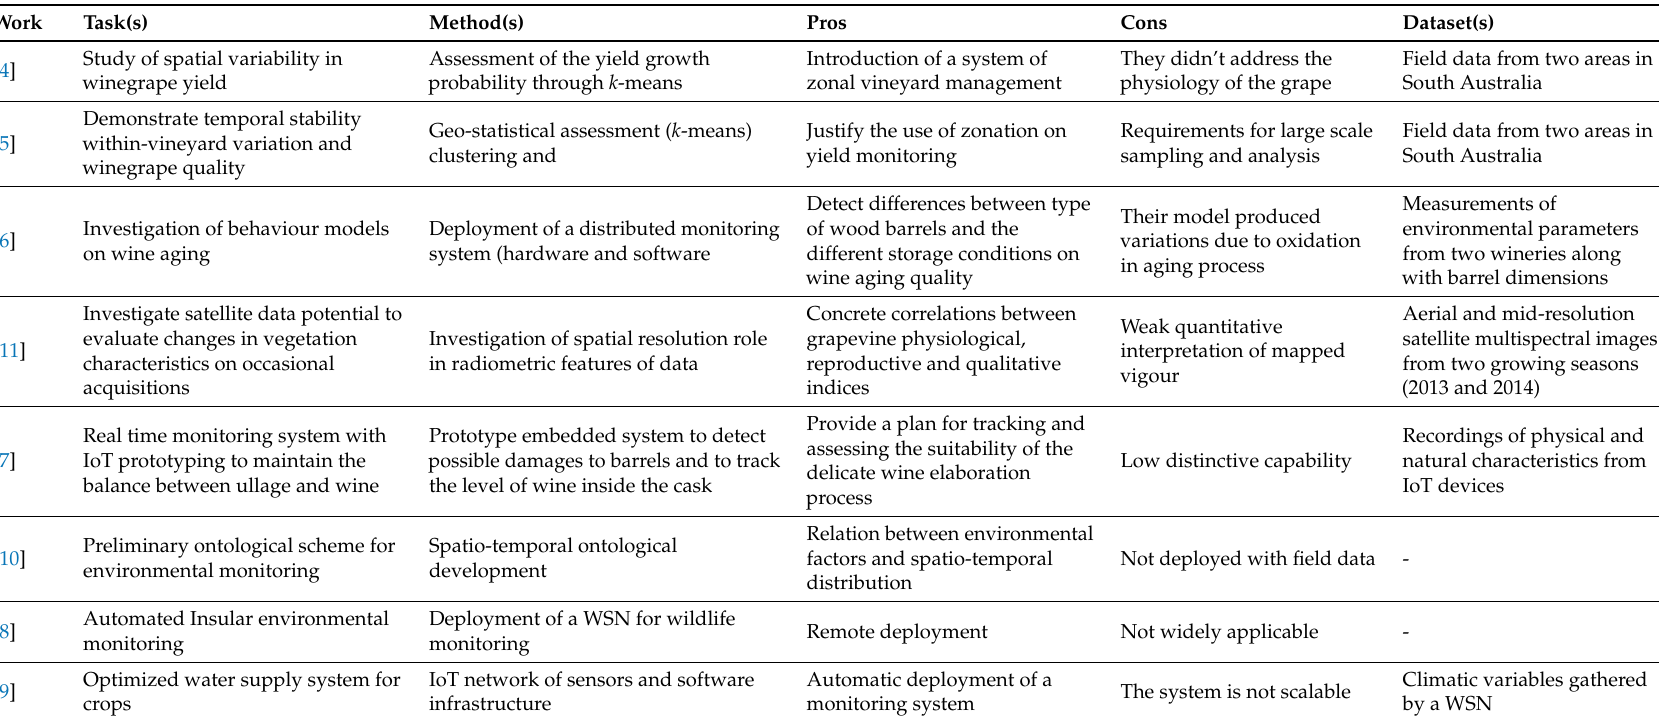
Table 1. Overview of research works in smart